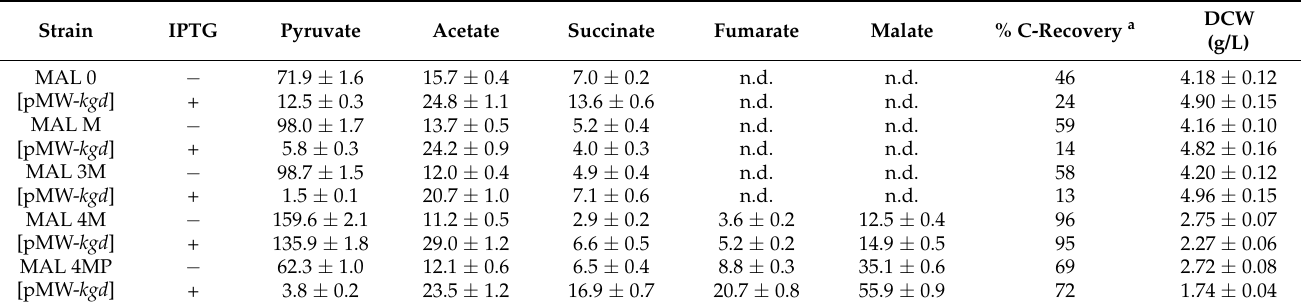
Table 2. Molar yields of metabolites produced by the MAL 0 [pMW- kgd ], MAL M [pMW- kgd ], MAL 3M [pMW- kgd ], MAL 4M [pMW- kgd ], and MAL 4MP [pMW- kgd ] strains during 8 h of aerobic glucose